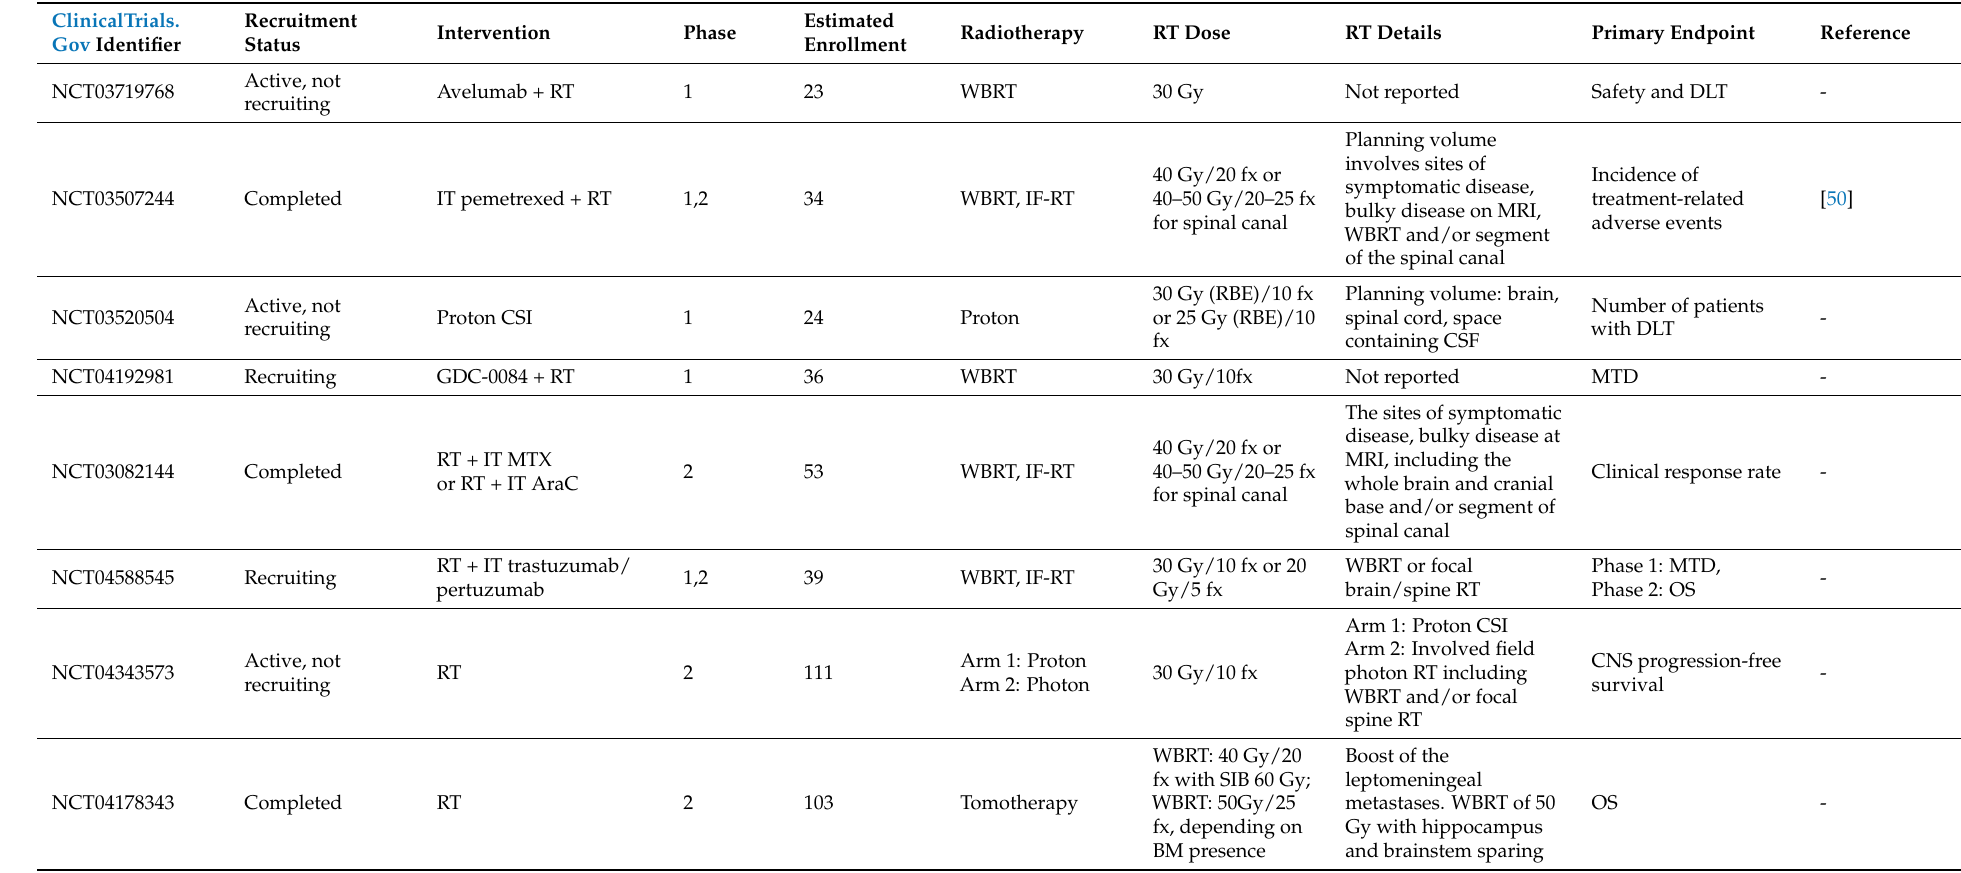
Table 5. Clinical trials involving radiotherapy for leptomeningeal carcinomatosis in breast cancer (ClinicalTrials.gov database). ClinicalTrials. Gov